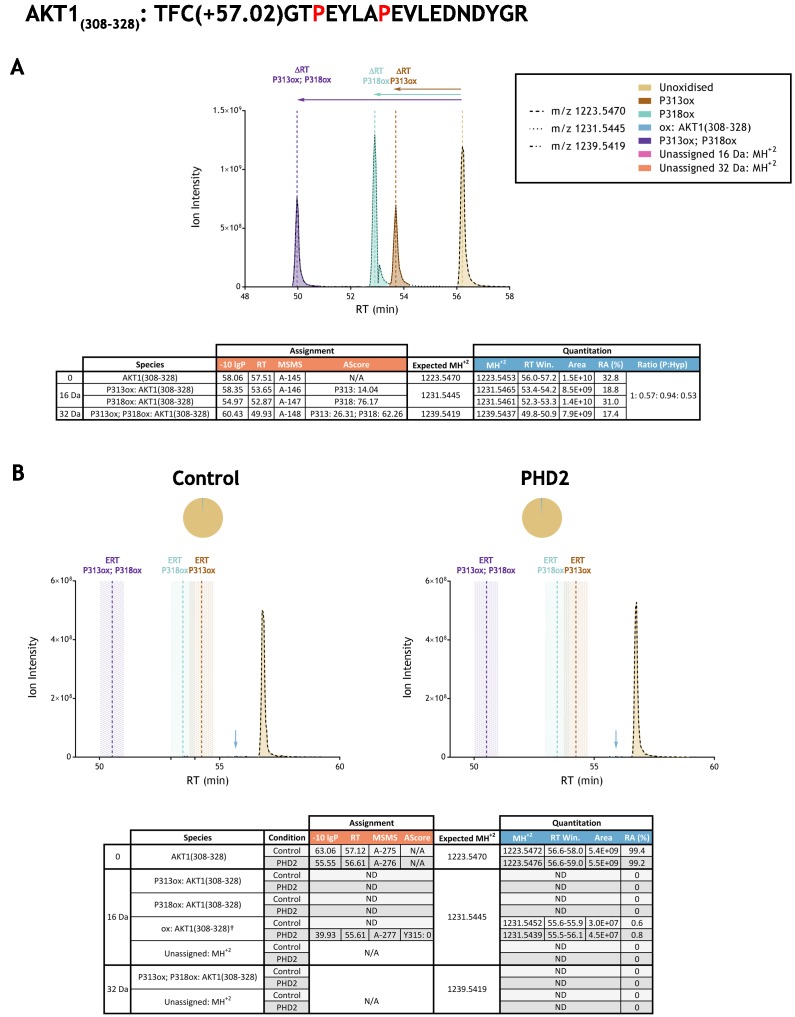
Quantitation of peptide oxidation on AKT1(308–328) following reaction of full-length AKT serine/threonine kinase 1 with recombinant PHD2.XIC data presented in (A) shows ion intensity and retention time (RT) characteristics of equimolar synthetic peptide standards for unoxidised and proline oxidised forms (P313ox, P318ox or combined) of the AKT1(308–328) peptide. MSMS assigned species are coloured (see inset); vertical dashed lines define peak maxima used to derive ΔRT values for the different hydroxyproline-containing peptides. Panel (B) shows comparable XIC data for protease-digested IVTT substrate under control (left) or PHD2-reacted (right) conditions. Peaks corresponding to unoxidised AKT1(308–328) were detected in both control and enzyme reacted conditions. An oxidised form of AKT1(308–328) was detected in the PHD2-reacted preparation (blue arrow) and was nominally localised to Tyrosine 315 (assignment was ambiguous, AScore 0; see Supplementary file 1 A-277 for MSMS). The elution profile of this low abundance oxidised ion, which was also observed in the control data, was distinct from the expected retention time (ERT) of hydroxyproline-containing peptides (indicated by dashed vertical lines; shading corresponds to a 1 min RT window). Unassigned ions with a compatible mass over charge for oxidation (including +16 Da and +32 Da species) were not observed across the elution window. Quantitative data for observed species are presented as pie charts with XIC data. Assignment and quantitation data are tabulated below each panel, table headers are as follows: (−10lgP) significance score of leading assignment at given (RT) with ambiguity score (AScore) for PTM localisation and reference to primary MSMS data in Supplementary file 1. Species column: †Fragment ions (including neutral loss) localise oxidation to residues 313–315. Quantitative data reports ion counts (Area) of observed masses (MH+2) integrated over time (RT Win.), expressed as relative abundance (RA). Data on detection efficiency for synthetic peptides (Panel A, P: Hyp) is an aggregated ratio of prolyl (P) to hydroxyprolyl (Hyp) containing species.